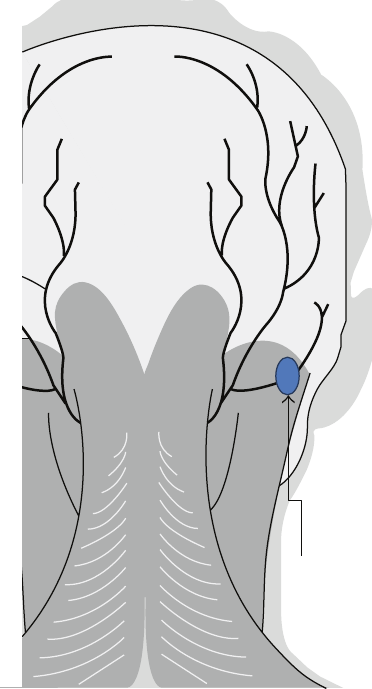
Figure 1: Oval represents point of maximal tenderness along the lesser occipital nerve. RF cannulae were positioned at the superior, inferior, medial, and lateral aspects of the point of maximal tender- ness prior to pulsed